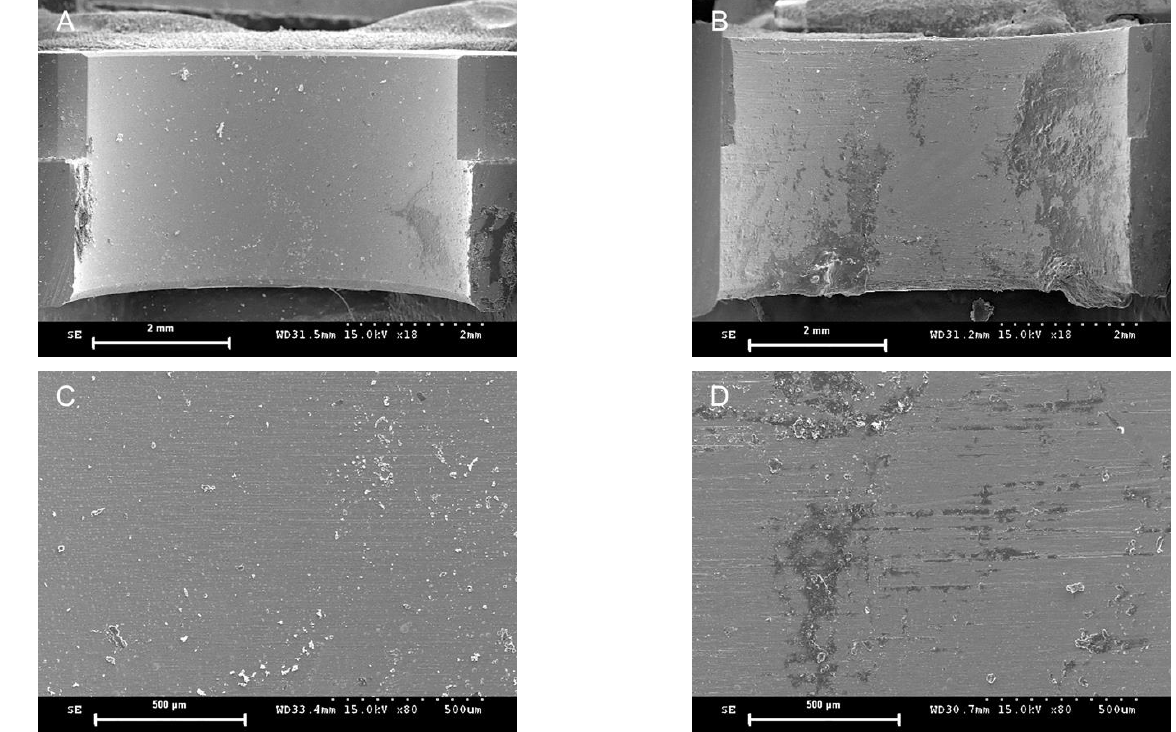
Figure 7. Representative scanning electron microscopic images. Cross-sectional view of a sleeve insert from a preoperative ( A ) and a postoperative ( B ) image from the MSI group at a lower magnification (18×). Cross-sectional view of a sleeve insert from a preoperative ( C ) and a postoperative ( D ) image from the MSI group at a higher magnification (80×).